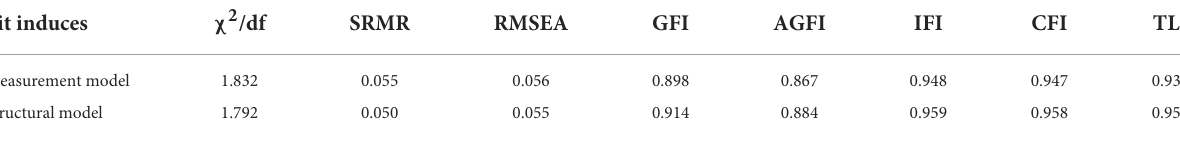
TABLE 5 Fit indices of measurement and structural model.